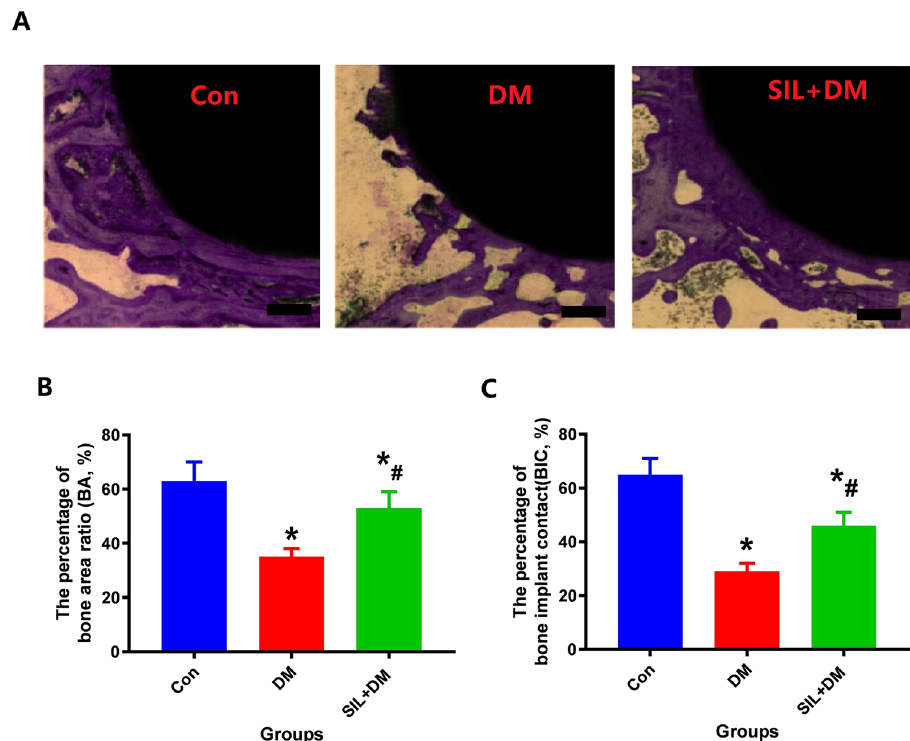
Fig. 5 Local administrator SIL can signi fi cantly improve the bone formation around the titanium rod and increase the connection of bone tissue and internal plants in the diabetic rat model. A : Bone formation around titanium rods under different intervention conditions; Scale bar: 100 µm. B : The percentage of bone implant contact(BIC, %); C : The bone area ratio (BA, %); N = 5 specimens/group; error bars in the fi gure indicate